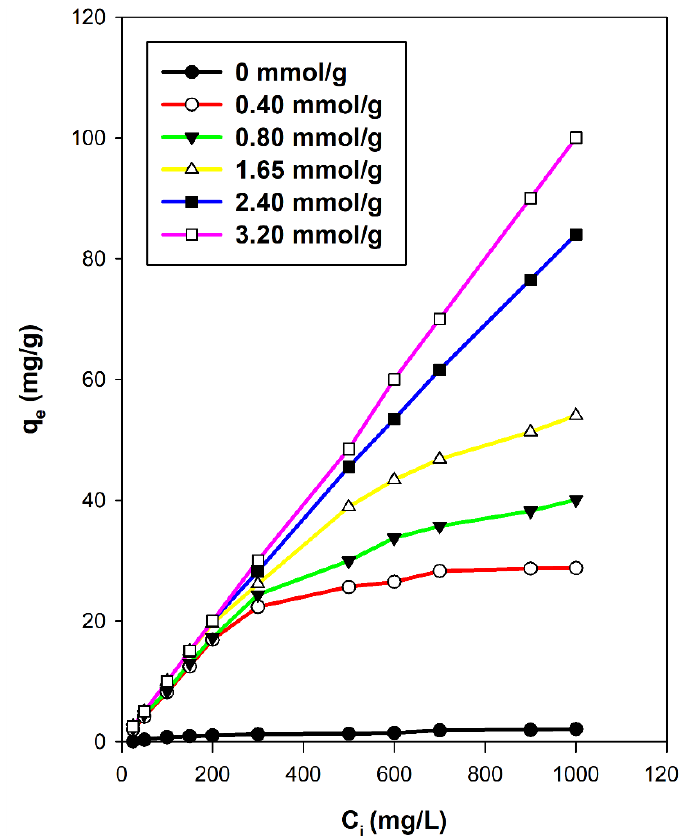
Figure 14. Removal of eosin using organo-clay prepared from C16TMABr solution using different initial loading concentrations.